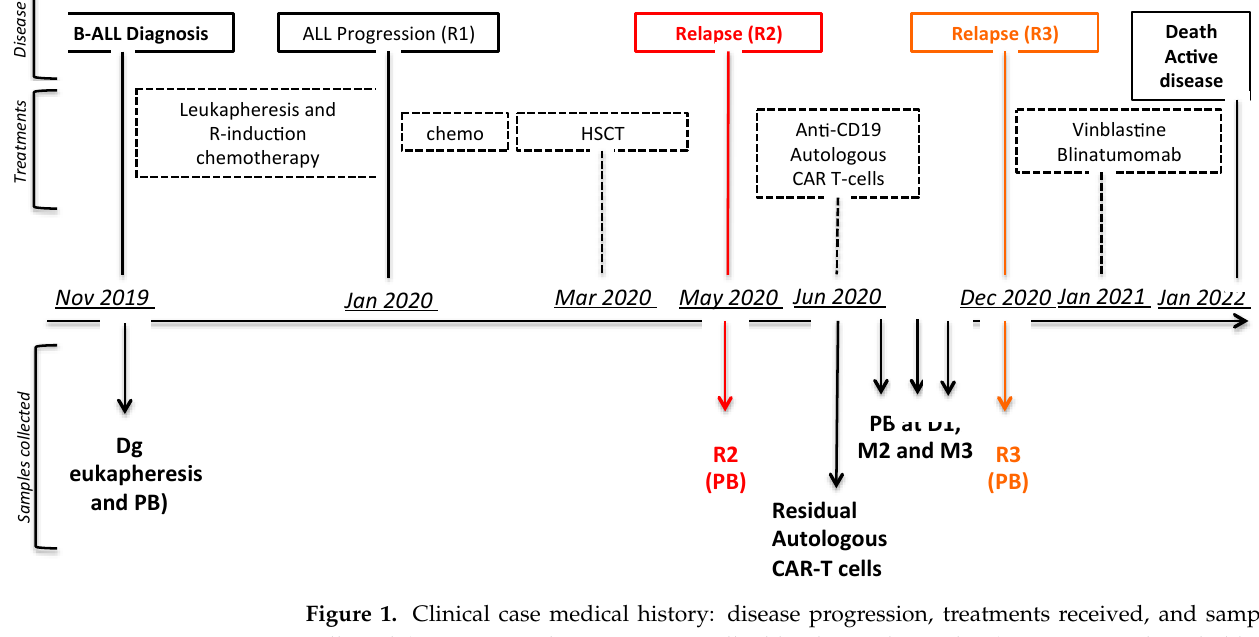
Figure 1. Clinical case medical history: disease progression, treatments received, and samples collected (Dg; R2; autologous CAR-T cells, blood samples and R3); ALL: acute lymphoblastic leukaemia; R: rituximab; HSCT: haematopoietic stem cell transplantation; PB: peripheral blood; chemo: chemotherapy.